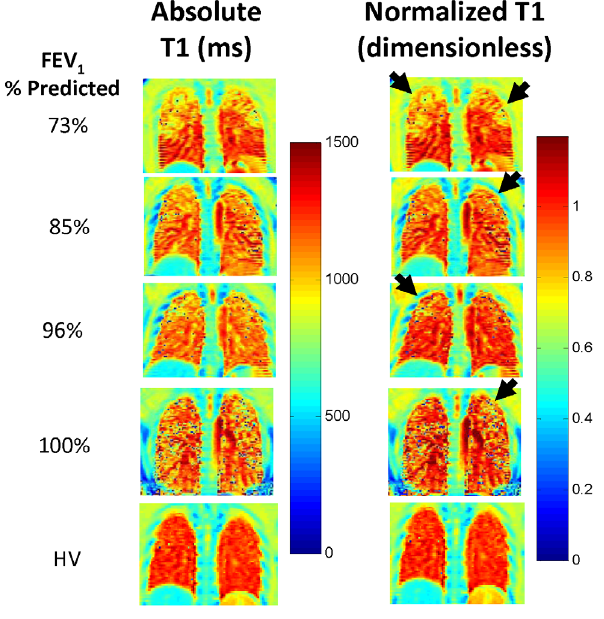
Figure 3. Absolute and Normalized T1 Maps from CF Patients. Representative absolute (left column) and normalized (right column) T1 relaxation time maps from four CF subjects (top four rows, FEV 1 :73%– 100% predicted) and one healthy volunteer (HV, bottom row). Regions of decreased normalized T1 indicative of diseased lung are clearly visible in the normalized T1 maps (black arrows). Note also the spatial heterogeneity in the nT1 maps from the CF patients in comparison to the uniform nT1 map of the healthy volunteer (HV).